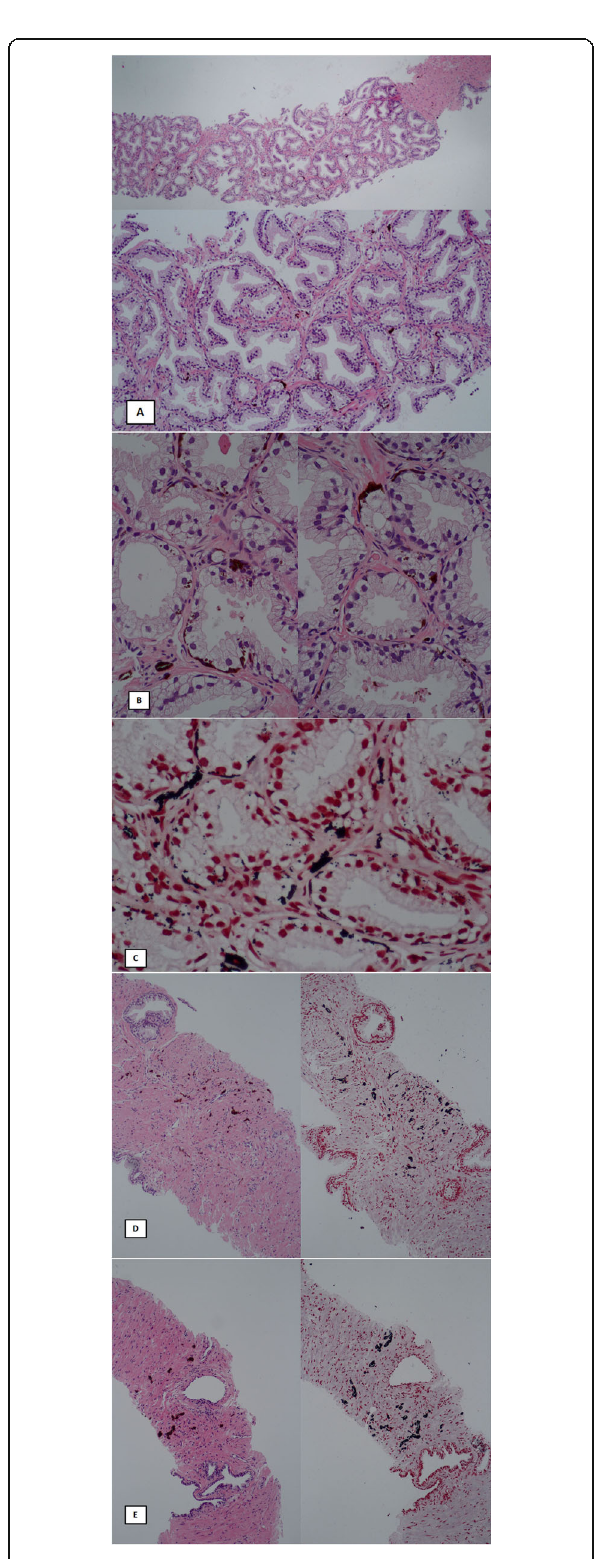
Fig. 2 Prostatic melanosis at needle biopsy. a right apex posteromedial – stromal cells with melanin at 40x and 100x magnification (HE). b right apex posteromedial – melanin deposits are seen in stromal cells and within glandular epithelium (HE, 400x) c right apex posteromedial – melanin deposits in stromal cells and within glandular epithelium stained with Fontana-Masson (400x). d Left mid posterolateral – stromal cells containing melanin; comparison of the same area with HE and Fontana-Masson (100x). e Left mid posterolateral – stromal cells containing melanin; comparison of the same area with HE and Fontana-Masson